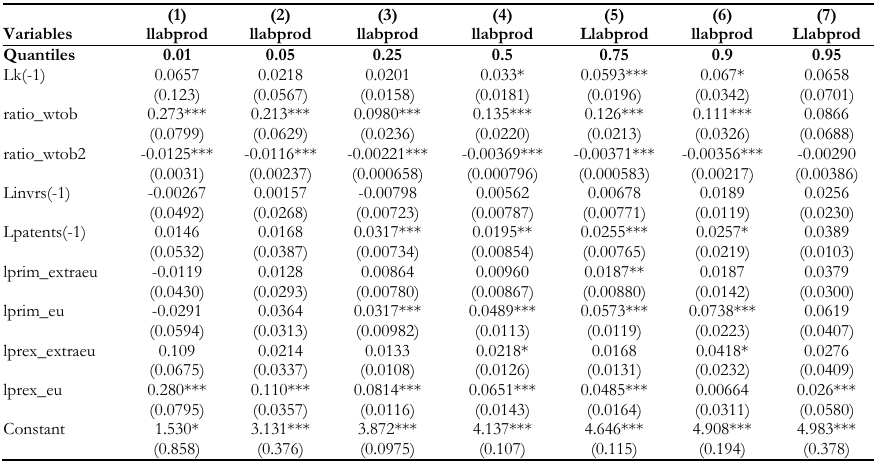
Quantile Regression Results for selected sectors: